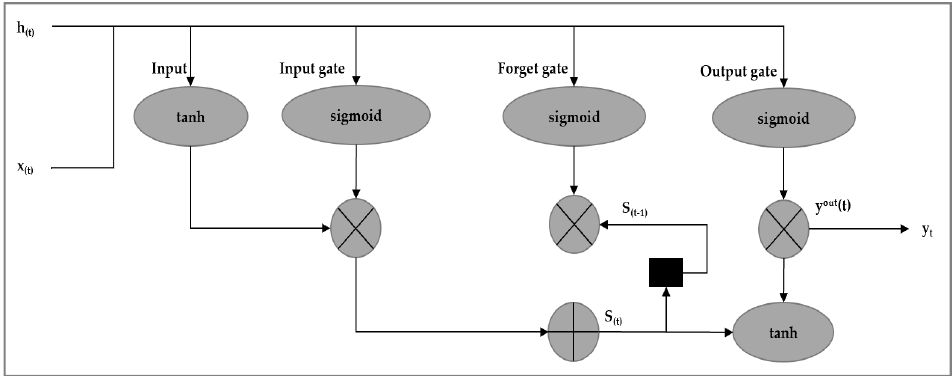
Figure 2. One cell in a basic LSTM network.